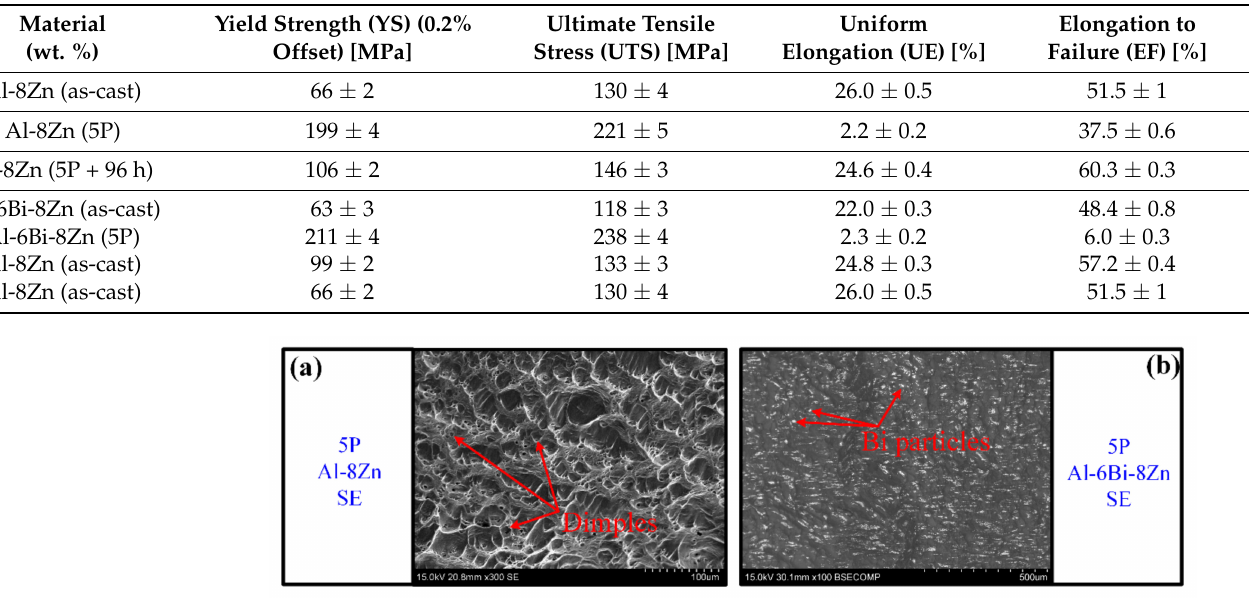
Figure 10. Fracture morphologies. ( a ) SE images of the 5P Al-8Zn sample, ( b ) BSE image of the 5P Al-6Bi-8Zn